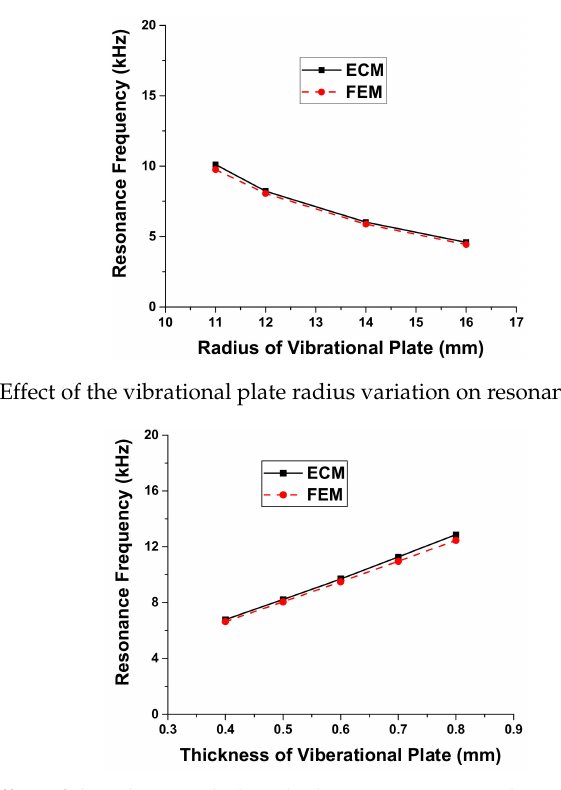
Figure 6. Effect of the vibrational plate thickness variation on the resonance